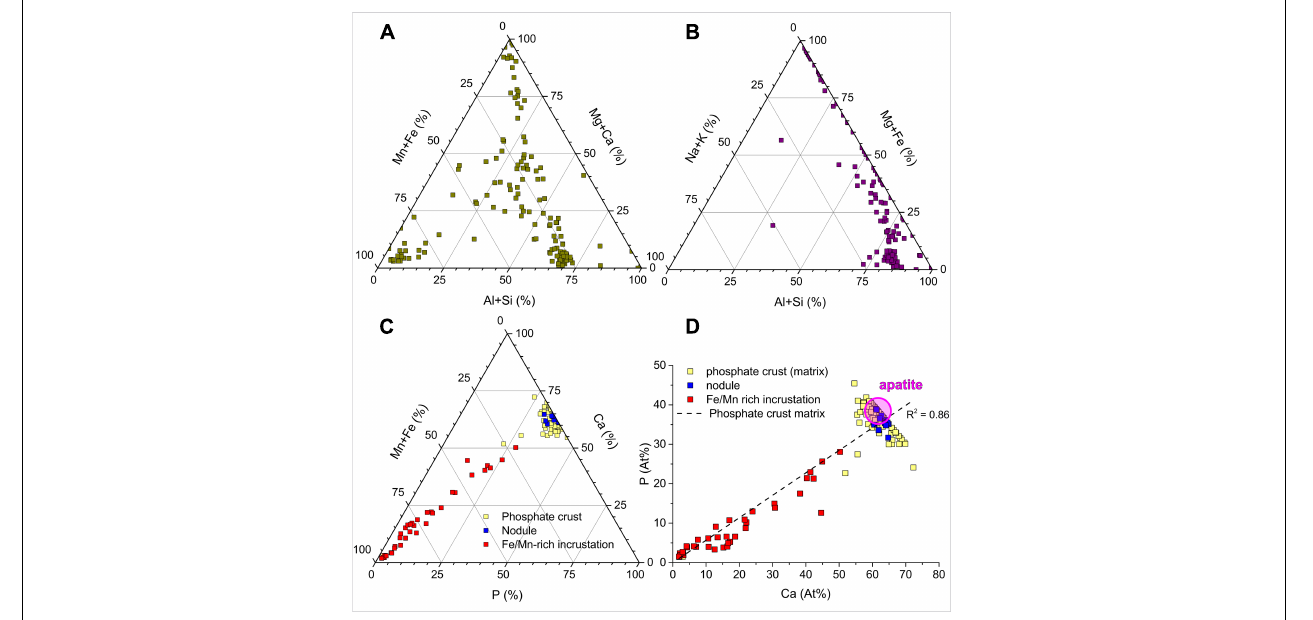
FIGURE 3 | (A) Ternary diagram showing the relative atomic% of Al + Si, Mg + Ca and Mn + Fe fractions of the clastic grains enclosed in phosphate crusts; (B) ternary diagram showing relative atomic% of Al + Si, Na + K and Mg + Fe fractions of the clastic grains enclosed in phosphate crusts; (C) ternary diagram showing the relative atomic% of P, Mg + Ca and Mn + Fe fractions of the crust’s matrix; (D) scatter plot of Ca and P atomic% on Ca + P + Mn + Fe obtained with SEM-EDS micro-analysis of crusts’ matrix: the dashed line represents the theoretical molar ratio of apatite, while pure apatite is approximately represented by the purple